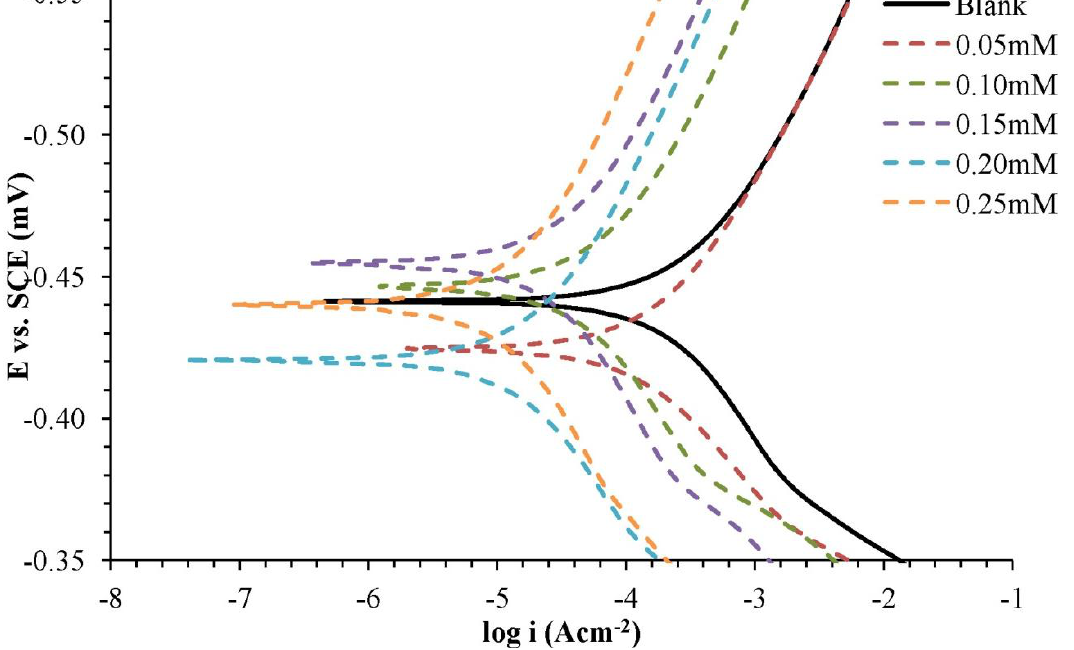
SO with different 2 4